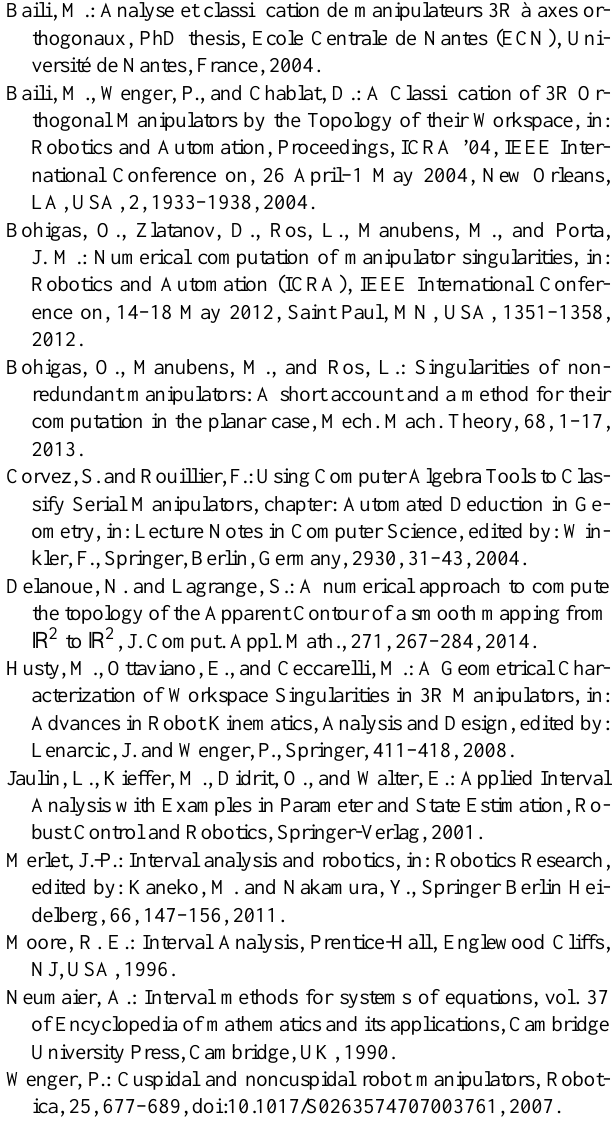
algorithm, alternate methods for splitting and localized tests need to be used and are still